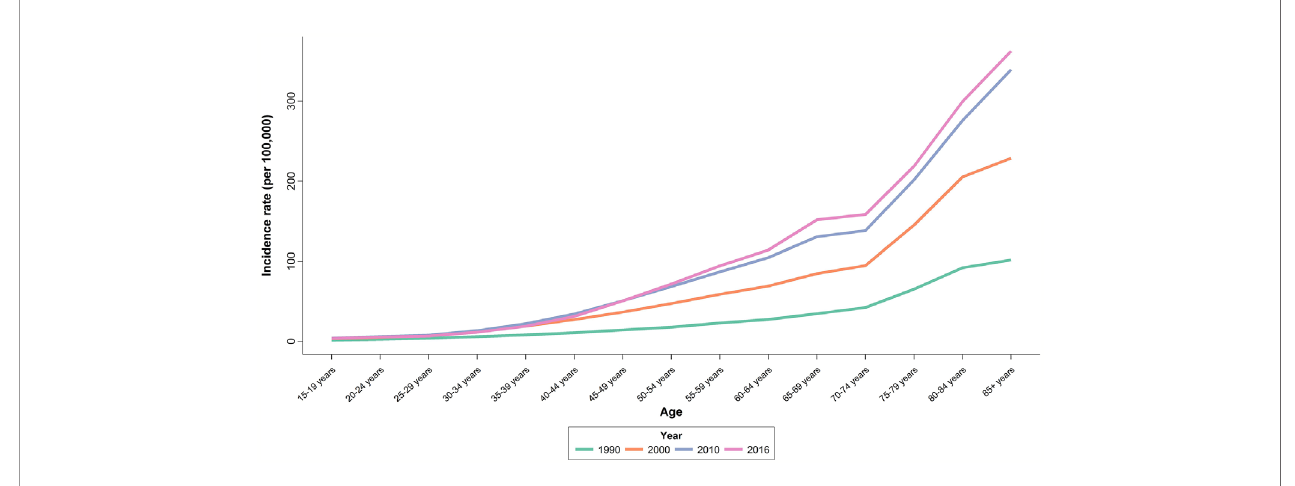
FIGURE 1 | National age trend of incidence rate in 1990, 2000, 2010,